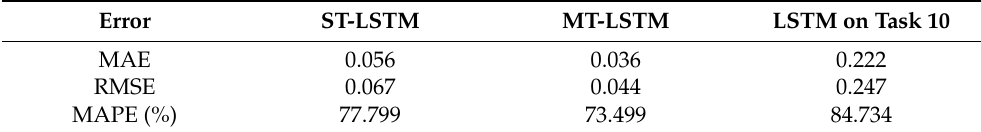
Figure 13. Prediction results of MT-LSTM, ST-MTGP, and LSTM for the extreme situation (after normalization). Table 9. Error results of MT-LSTM, ST-LSTM, and LSTM (after normalization). Table 8. Error results of STGP and MTGP (after normalization).